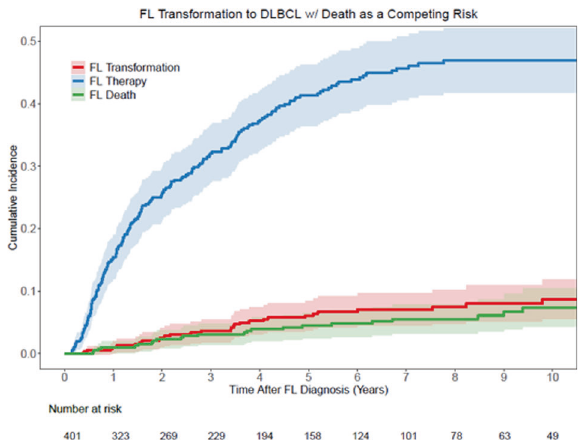
Fig. 1 Estimates of treatment initiation from the time of diagnosis. Cumulative incidence estimates of treatment initiation with transformation and death as competing